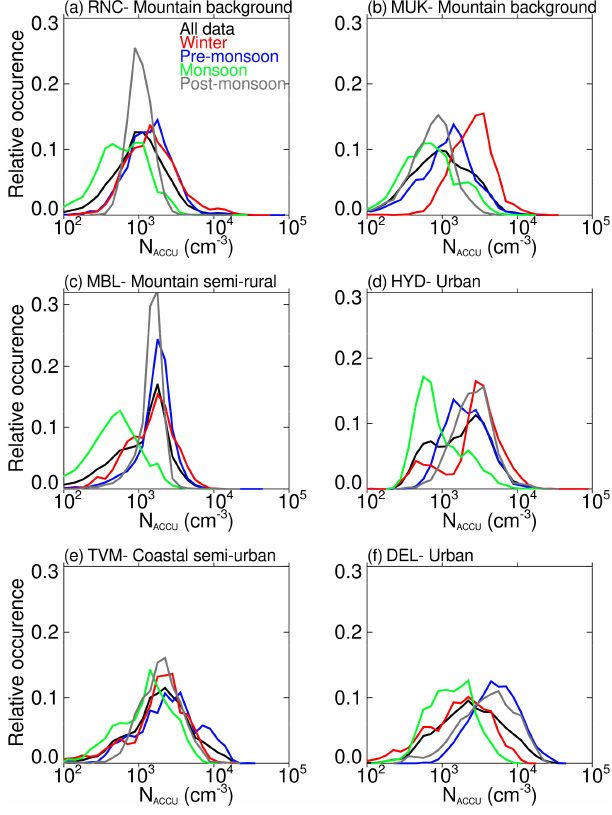
Figure 7. Histogram of the relative occurrence of accumulation mode particle number concentrations at the sites. The concentration bins are logarithmically spaced on the x axis, and the y axis shows the relative occurrence of values in each bin compared to the total number of valid observations. The black, blue, red, green, and gray lines indicate all data, winter (DJF), pre-monsoon (MAM), mon- soon (JJAS), and post-monsoon (ON), respectively. n indicates the number of 10min averaged valid data points. Note that measure- ments are from different time periods for each site (see Table 1).